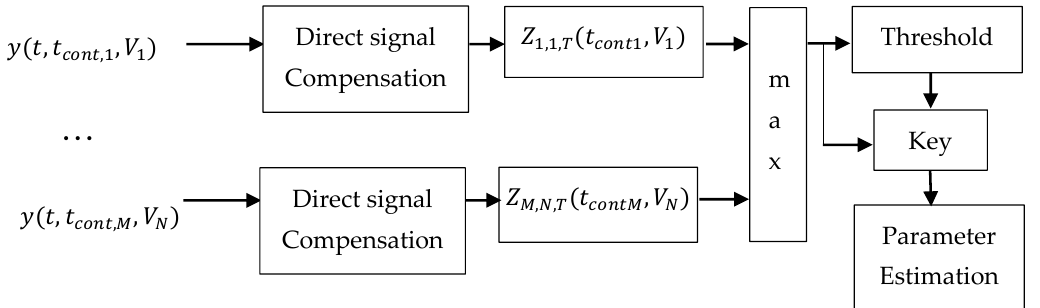
Figure 3. Algorithm for detection of the forward scattering signal from an airplane.